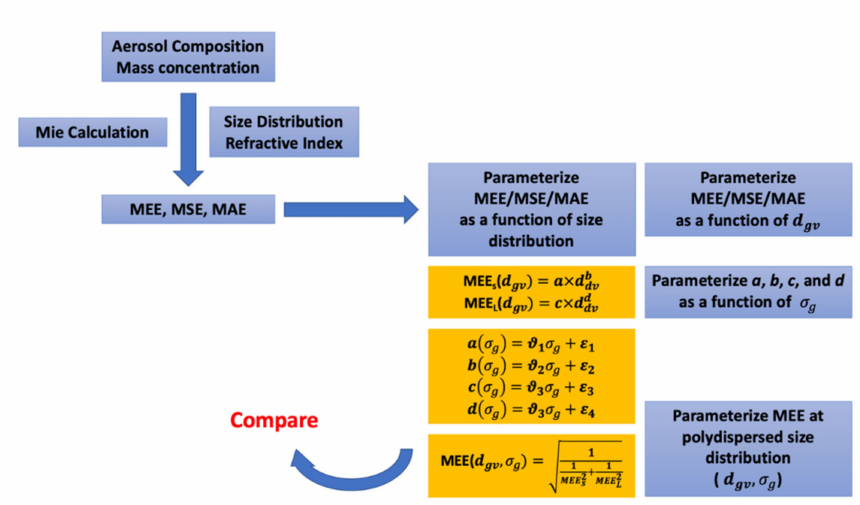
Figure 3. Schematic diagram for the calculations of mass extinction e ffi ciency (MEE) approximation for polydisperse aerosol particles in this study. Mass scattering e ffi ciency (MSE), mass absorption e ffi ciency (MAE), MEE for small particle size range (MEE S ), MEE for large particle size range (MEE L ), geometric volume–mean diameter ( d gv ), and geometric standard deviation ( σ g ) are also